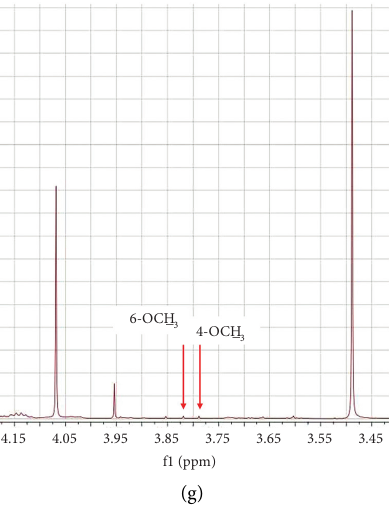
Figure 1: 1 H NMR spectra of three Zanthoxylum species— Z . bungeanum (a, c), Z . schinifolium (d, e), and Z . piperitum (f, g)—and the structure of xanthoxylin (b). The 1 H NMR spectra corresponding to the signals of 4-OCH 3 and 6-OCH 3 in (a), (d), and (f) were magnified to (c), (e), and (g),